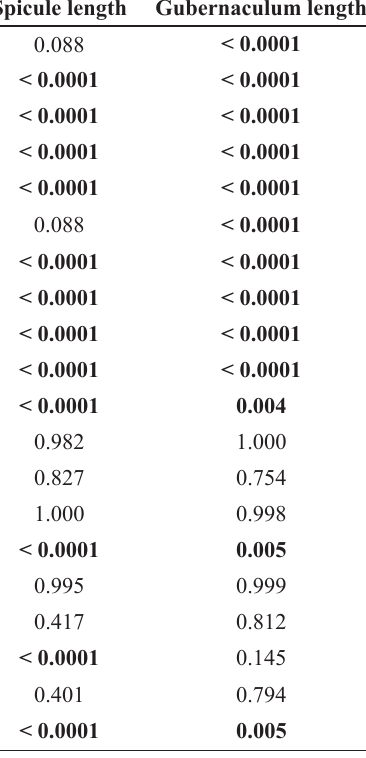
papillae at the same level as cloaca), and postcloacal papillae (see his Figure 3: two ventral pairs near the cloaca, one large and two small pairs in the middle region of the tail, and two small ventral pairs at the posterior third of the tail). This author referred to